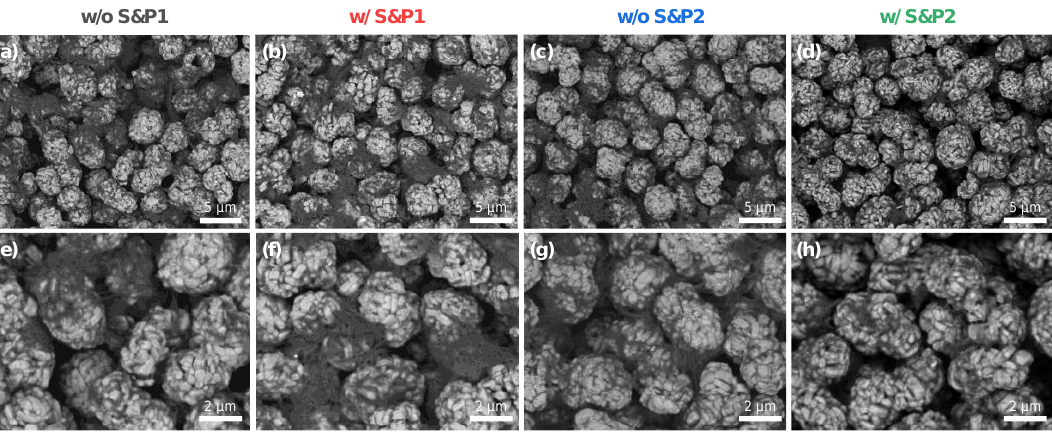
Figure 2. ( a – d ) Scanning electron microscopy (SEM) images of electrode surface and ( e – h ) zoomed-in image of without S&P1, with S&P1, without S&P2, and with S&P2, respectively.